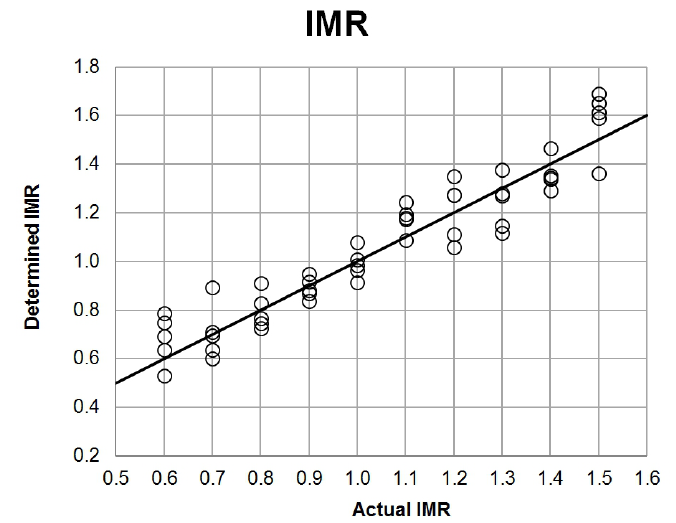
Figure 6. Actual and determined Inlet Molar Ratio (IMR) correlation